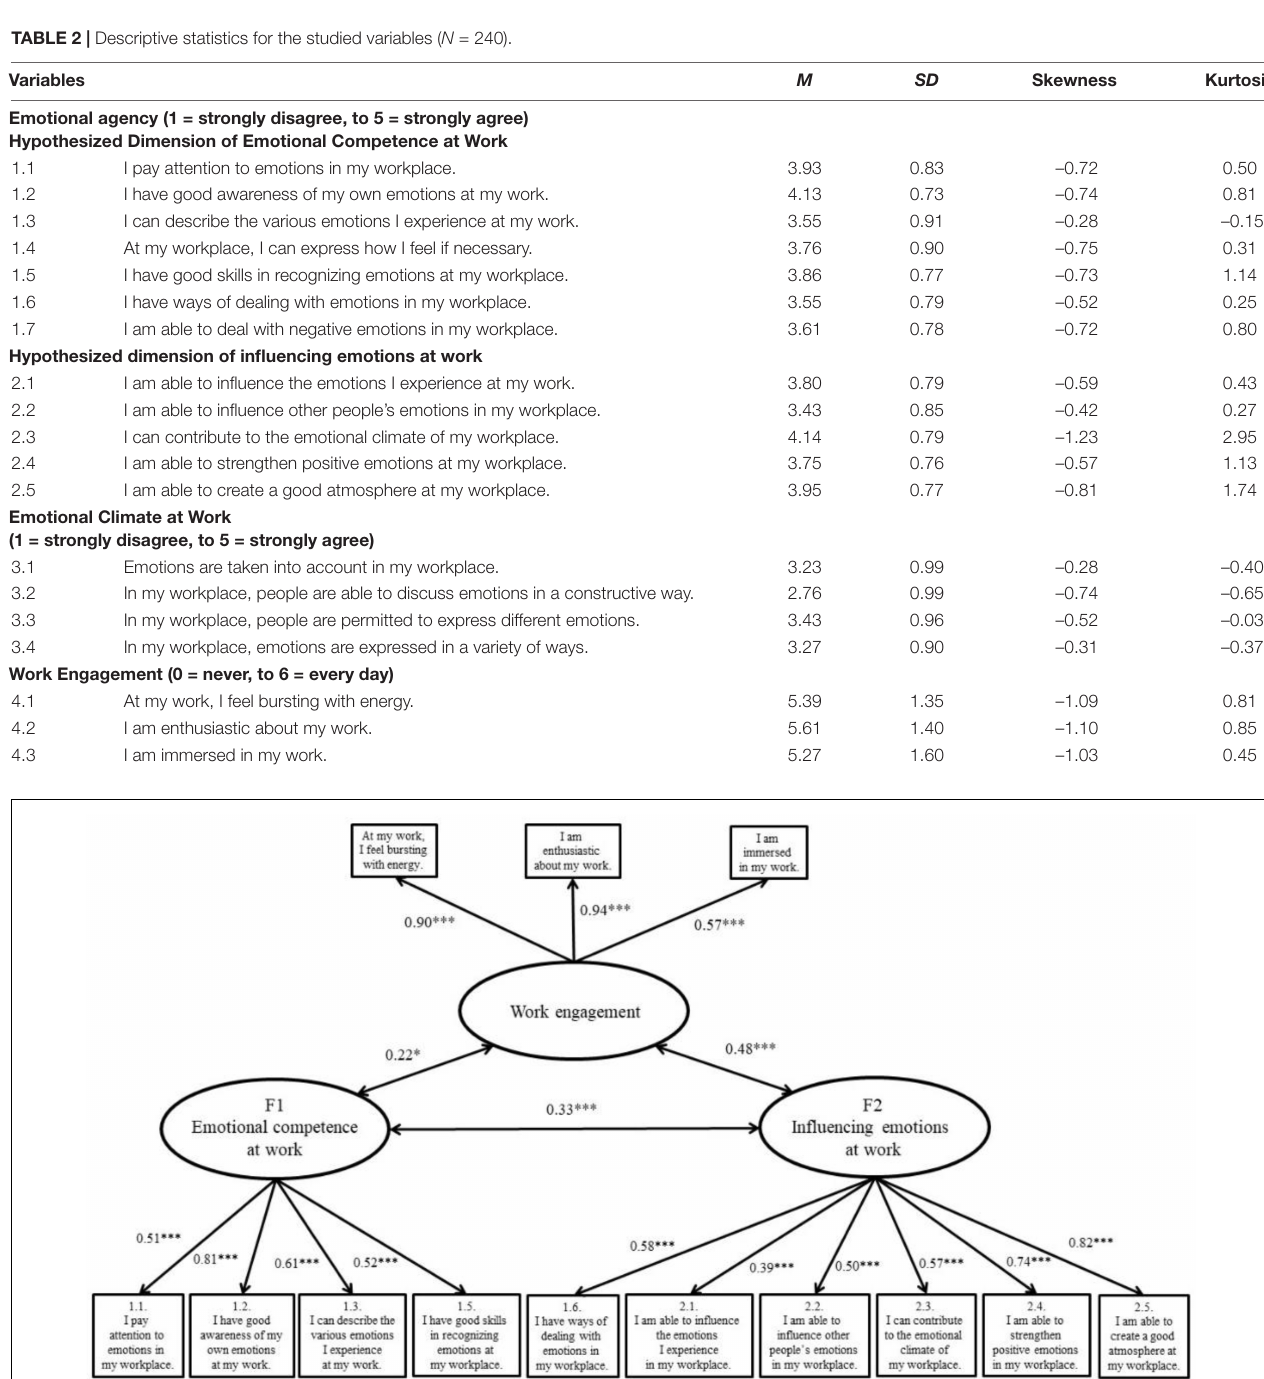
FIGURE 1 | Dimensions of emotional agency in relation to Work engagement ( N = 240). Standardized estimates are presented ( ∗ p < 0.05, ∗∗∗ p < 0.001). The numbers before the emotional agency items refer to the original item numbers shown in Table 1 . Fit statistics: χ 2 (53) = 68.32, p = 0.08; RMSEA = 0.04 [90% CI = 0.00–0.06], CFI = 0.98, TLI = 0.98; SRMR =